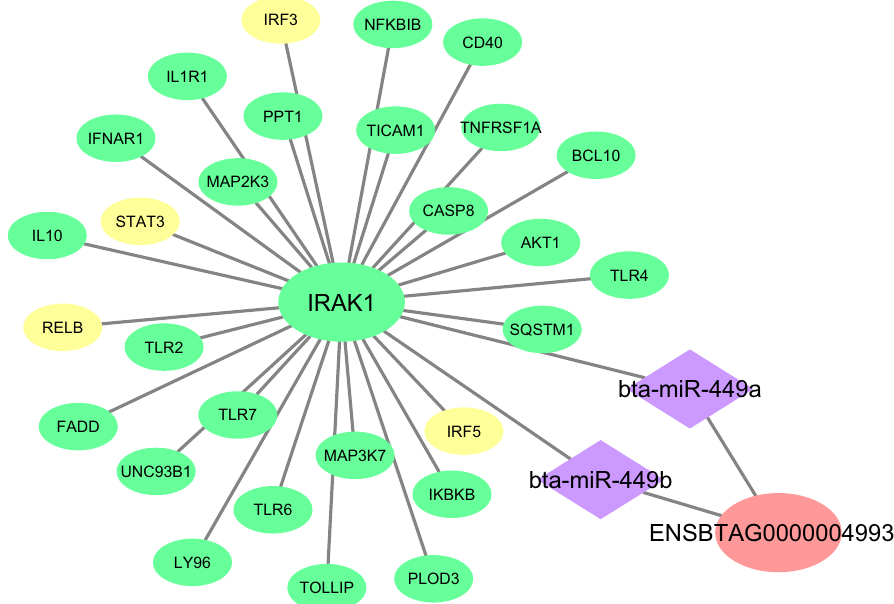
Figure 8. The constructed integrated regulatory sub-network related to IRAK1 gene in turquoise Rb-module. The green and yellow circles indicate hub genes and hub TFs related to IRAK1 , respectively. The purple diamonds represent the hub miRNAs that be predicted to regulate IRAK1 and hub-hub lncRNA ENSBTAG00000049936 . Cytoscape software (version 3.7.2) (https:// cytos cape. org/) was used to generate this